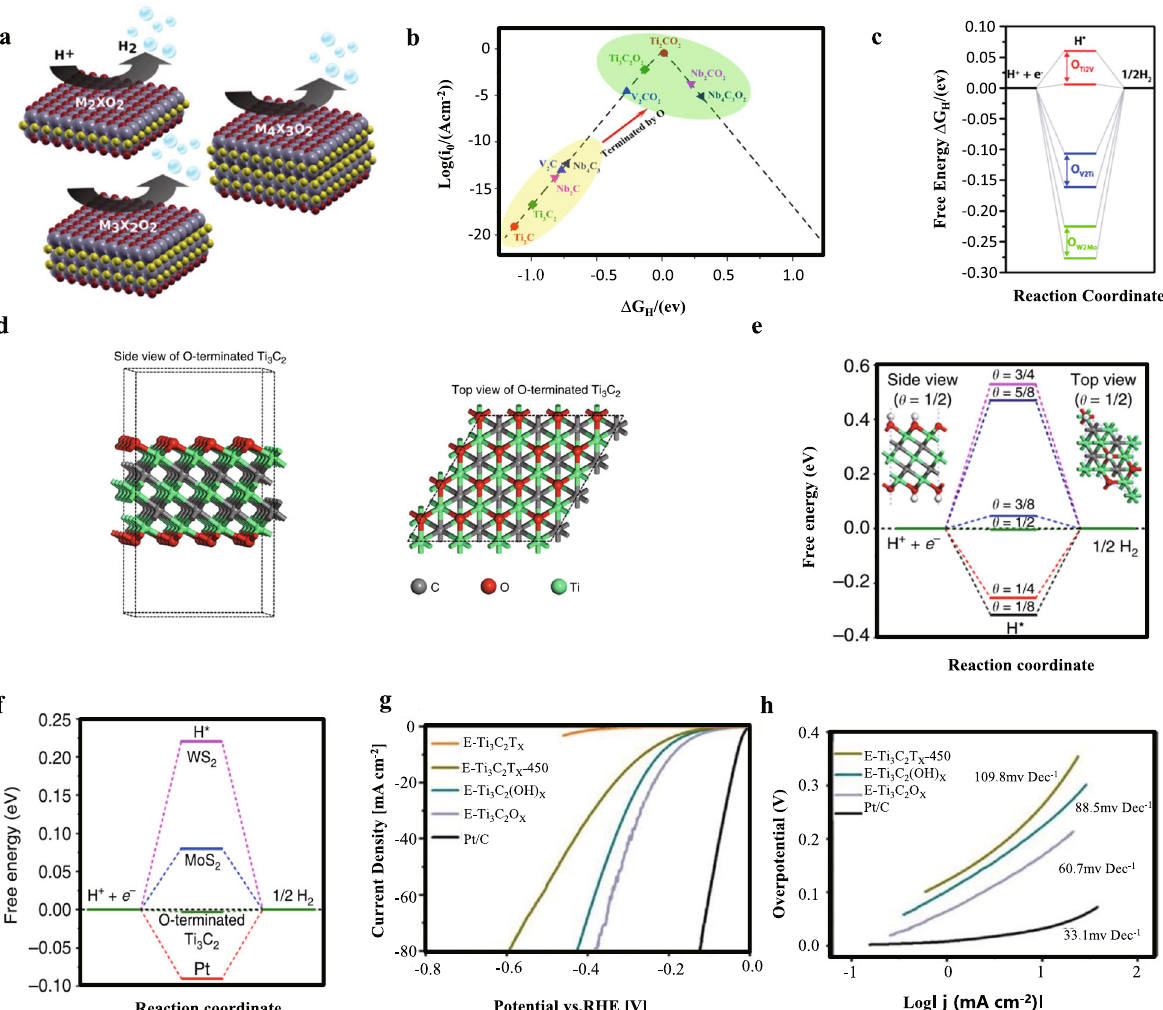
Fig. 7 MXenes-based HER electrocatalysts optimized by modifying their surface terminal groups. a Schematic of hydrogen evolution of MXenes with O-termination. b The correlation of exchange current (i 0 ) and Δ G H72 . Copyright 2016, American Chemical Society. c Calculated free-energy diagram of HER at equilibrium potential for O Ti2V1 , O V2Ti1 , and O W2Mo1 sites 74 . Copyright 2016, American Chemical Society. d The structure model for a 4*4*1 O-terminated Ti 3 C 2 supercell. e, f The calculated free-energy diagram of HER at the equilibrium potential on the surface of a 2*2*1 O-terminated Ti 3 C 2 supercell, and the referenced Pt, MoS 2 , and WS 273 . Copyright 2017, Springer Nature. g Polarization curves of